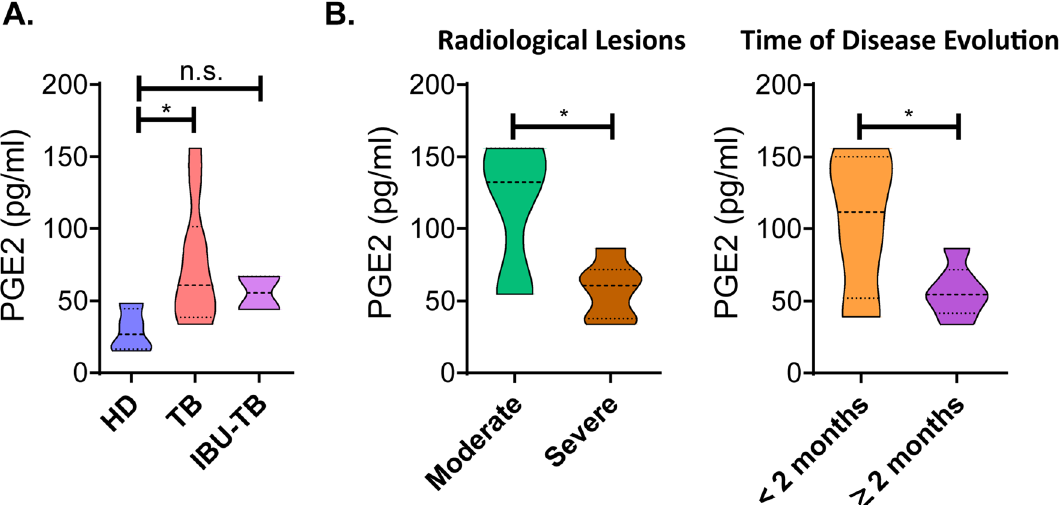
Figure 1. PGE2 plasma levels from Healthy Donors and tuberculosis patients. ( A ) Heparinized peripheral blood from HD (n = 5) and TB patients (n = 13) under ibuprofen treatment (IBU-TB) or not (TB) was centrifuged for 15 min at 1000 g and the levels of PGE2 in plasma were analyzed by RIA. ( B ) Plasmatic PGE2 levels in TB patients (n = 13) classified according to the severity of the disease. Briefly, the radiological lesions (moderate or severe) and the time of disease evolution (time previous to hospital admission during which the patient displays clinical symptoms) were determined. Violin plots show the median values of PGE2 plasma concentration (pg/ml) ± interquartile range. P values were calculated using the Mann Whitney non-parametric test for unpaired samples. * p <